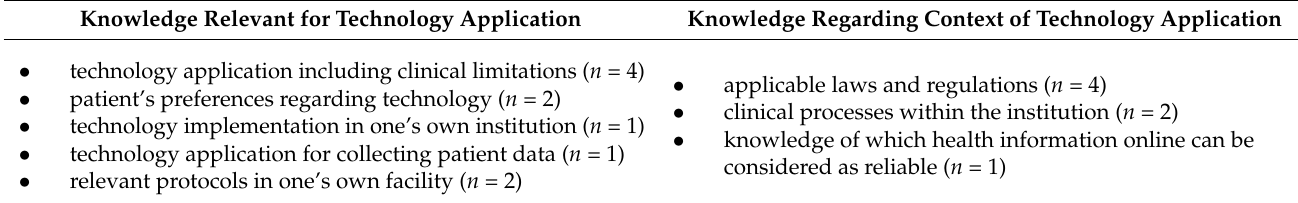
Table 3. Most relevant knowledge for telenursing as chosen by the Parkinson